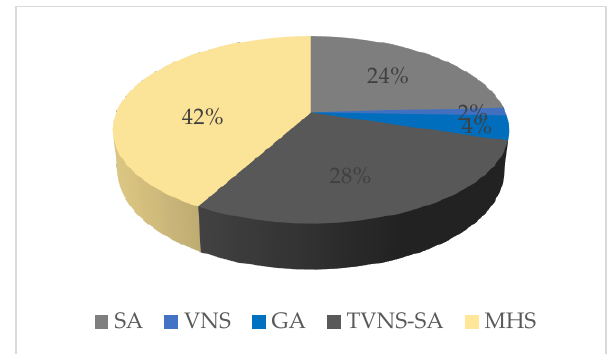
Figure 16. Overall percentage of different algorithms.